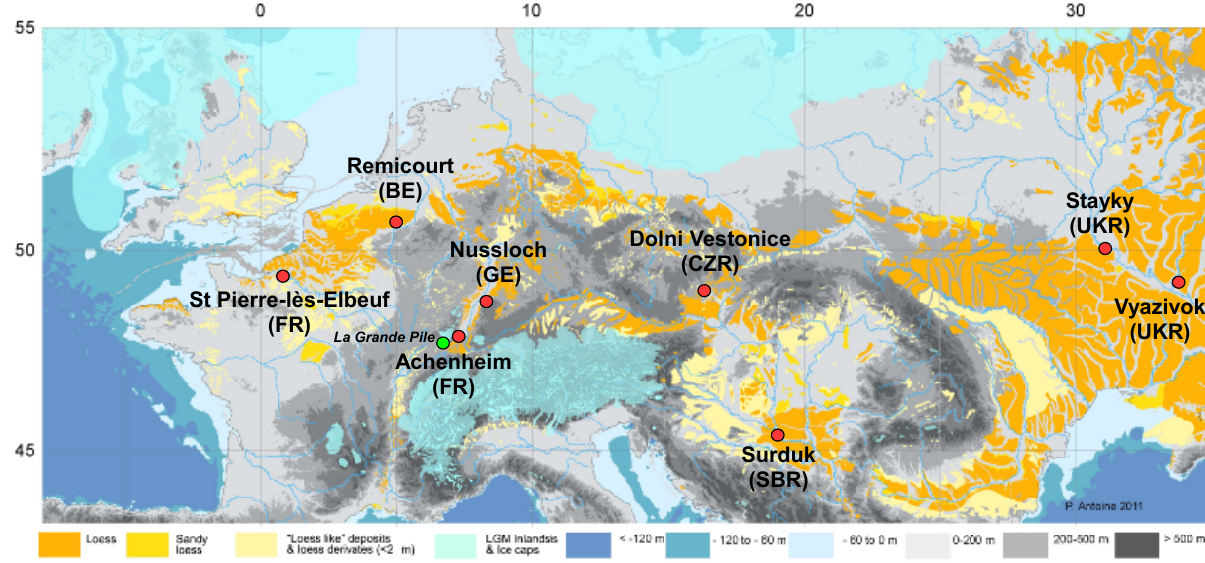
Fig. 2. Location of major European loess sequences. The map, adapted from Antoine et al. (2013), also shows the distribution of the loess deposits (in yellow) by thickness in Europe, as well as the extent of the continental ice sheets (light blue) and the estimated lowering of the sea level (emerged areas in light gray) at the last glacial